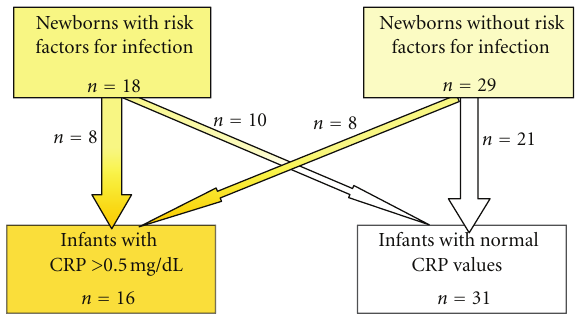
F 2: Study population and �nal assignment to the study